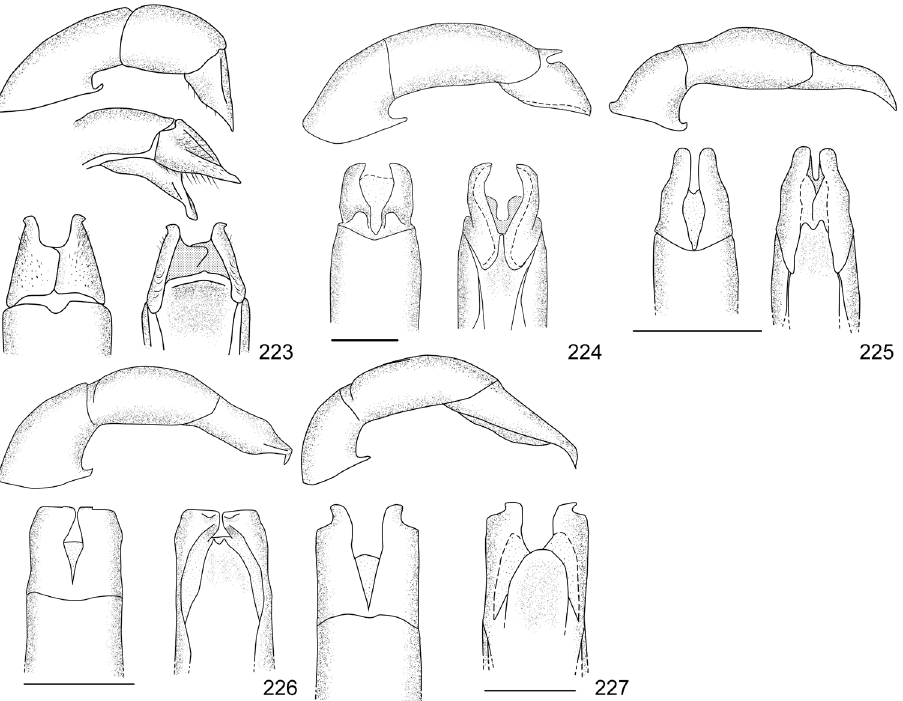
Figures 223–227. Shape of aedeagus, lateral view (top), dorsal view (bottom left), ventral view (bot- tom right). 223 Moroniella nitidula , below lateral view: detail of parameres when endophallus is everted (Lateral view: Guatemala, MNHUB; other: Zarcero, Alajuela, MNCR) 224 Strigoderma auriventris (Sec- tor San Ramón de dos ríos, Alajuela, MNCR) 225 Strigoderma biolleyi (Macizo de la Muerte, Cartago, MNCR) 226 S. nodulosa (Estación Quebrada Bonita, Puntarenas, MNCR) 227 S. sulcipennis (Finca Jenny, Guanacaste, MNCR). Scale bars: 1